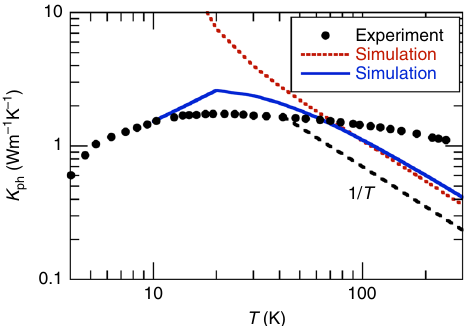
Fig. 7 Lattice thermal conductivity in Ba 7.81 Ge 40.67 Au 5.33 . Comparison between the experiment ( full circles ) and the anharmonic three phonon simulation ( red dotted line ) carried out using the experimental lattice parameter. The blue solid line includes boundary effect with a size of 500 nm. The dashed black line indicates the 1/ T decay. Other scattering mechanisms (defects, electron-phonon) needs to be included at temperature lower than 50